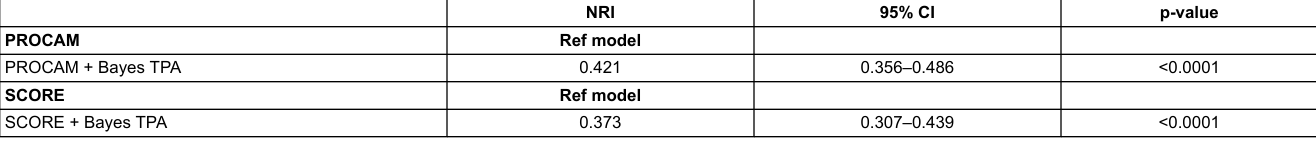
Table 4: Net reclassification improvement (NRI) using post-test risk of PROCAM and SCORE based on TPA tertiles derived sensitivities and specificities for observed outcome.